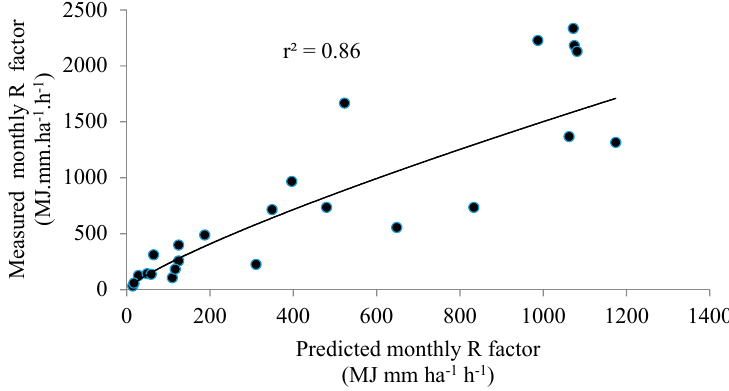
Figure 5. Scatter plot between predicted and estimated rainfall erosivity on the calibration data set.